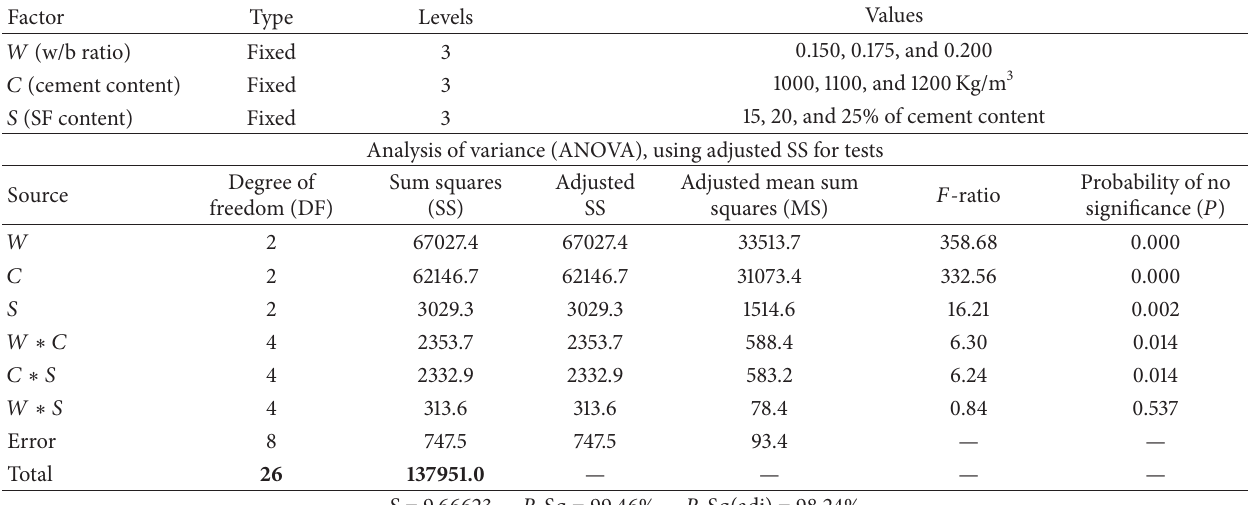
Table 4: Results of the ANOVA of the ultimate shrinkage (90-day)